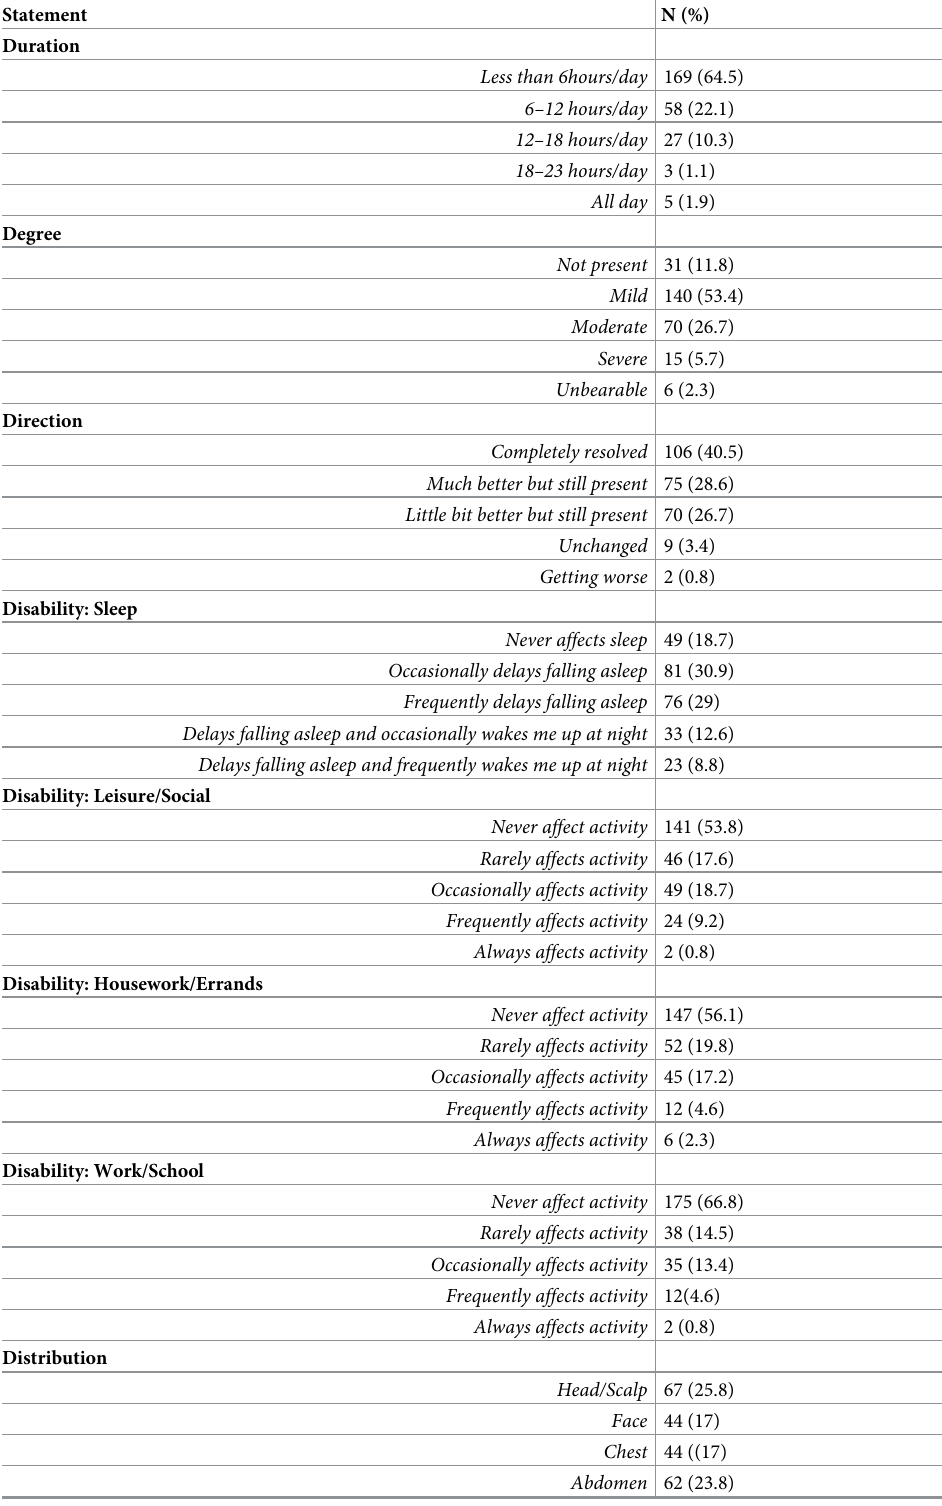
Table 2. Responses by respondents on Urdu 5D itch scale (n =